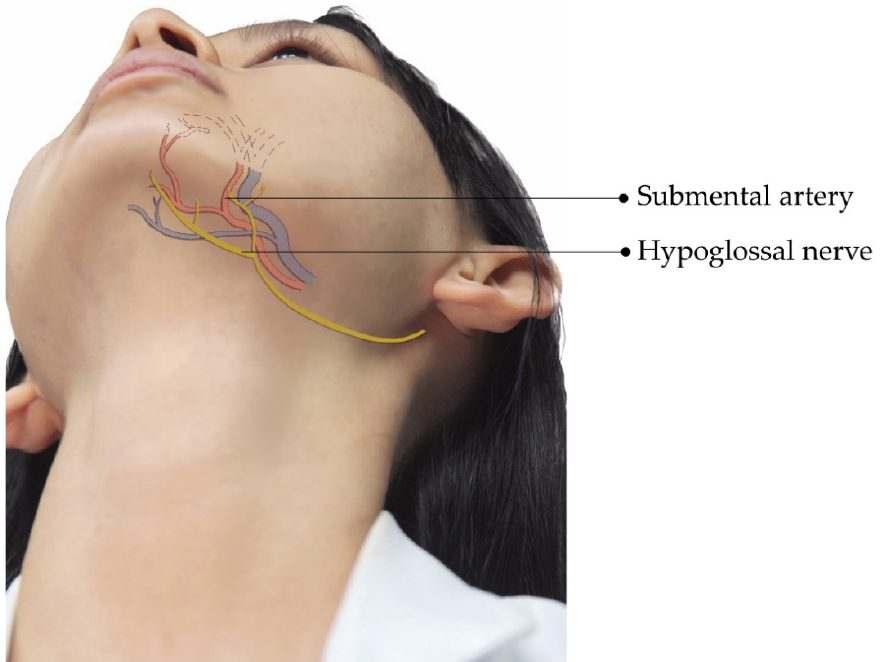
Figure 3. Illustration showing the submental facial neurovascular structures. Blue structures indicate veins, which are mostly accompanied by arteries (in red) with the same nomenclature.